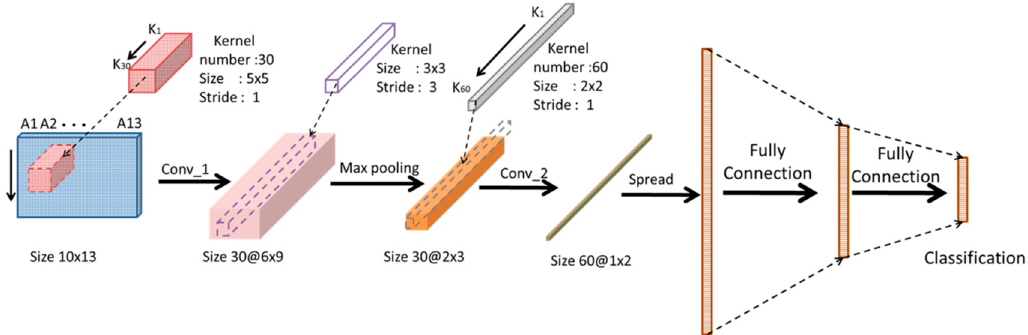
Figure 5. Convolutional neural network (CNN) architecture.